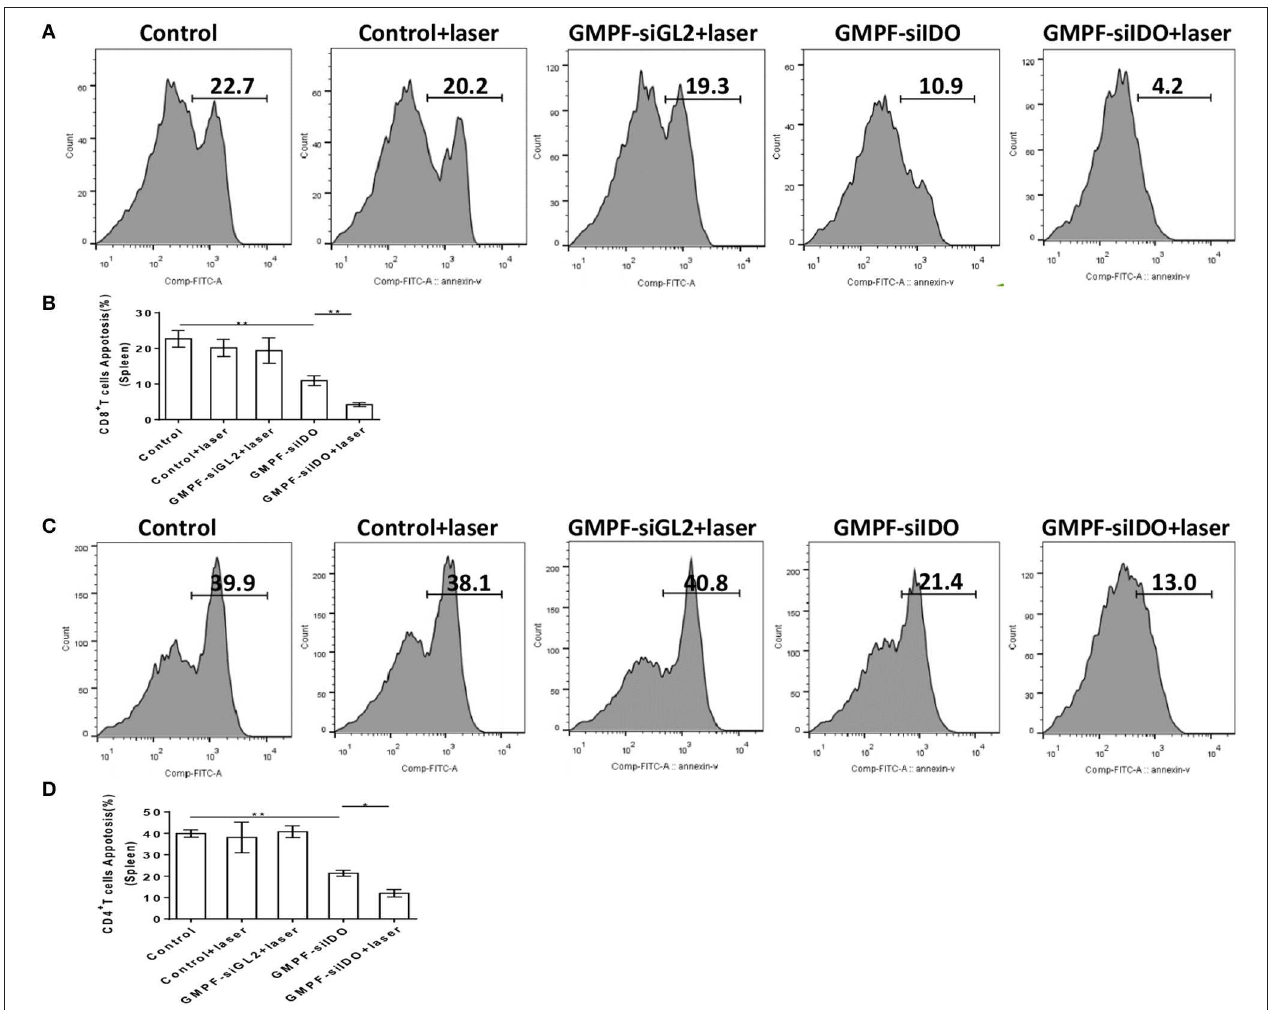
FIGURE 8 | Suppression of T cell apoptosis by photothermal-immunotherapy. Lung cancer-bearing mice were treated with PBS (control), GMPF-siGL2, or GMPF-siIDO, with or without laser irradiation. T cells were isolated and apoptosis of CD4 + (A) and CD8 + (C) T cells in spleens were analyzed by flow cytometry after Annexin V staining. The correspondent apoptotic percentages of CD8 + T cells (B) and CD4 + T cells (D) were calculated and results represent one of three experiments. Error bars represent the standard deviation of three experiments (* P < 0.05; ** P <